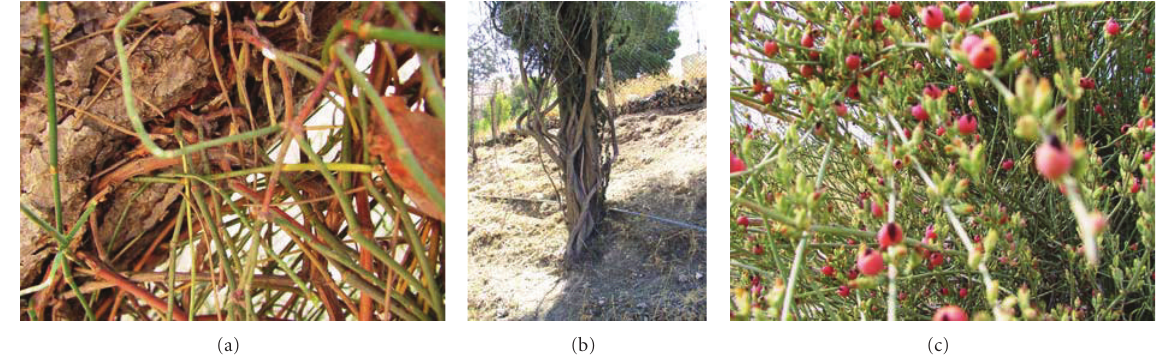
Figure 2: Joint-pine (a) aerial roots inserted in Pinus halepensis bark. (b) Emerged exactly with Cupressus sempervirens var. horizontalis. (c) Fruiting stage. Photos Scale: 36% ×